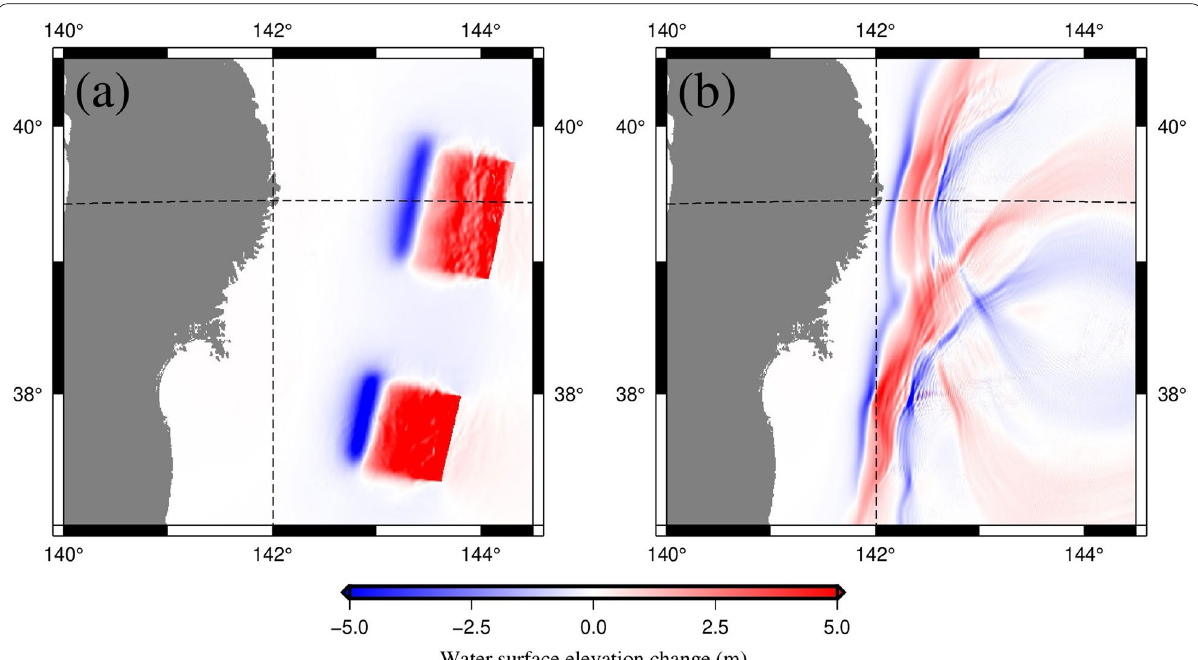
Fig. 6 Snapshots of ( a ) the initial tsunami deformation and ( b ) tsunami propagation. The point at which the two dashed lines cross indicates the location of